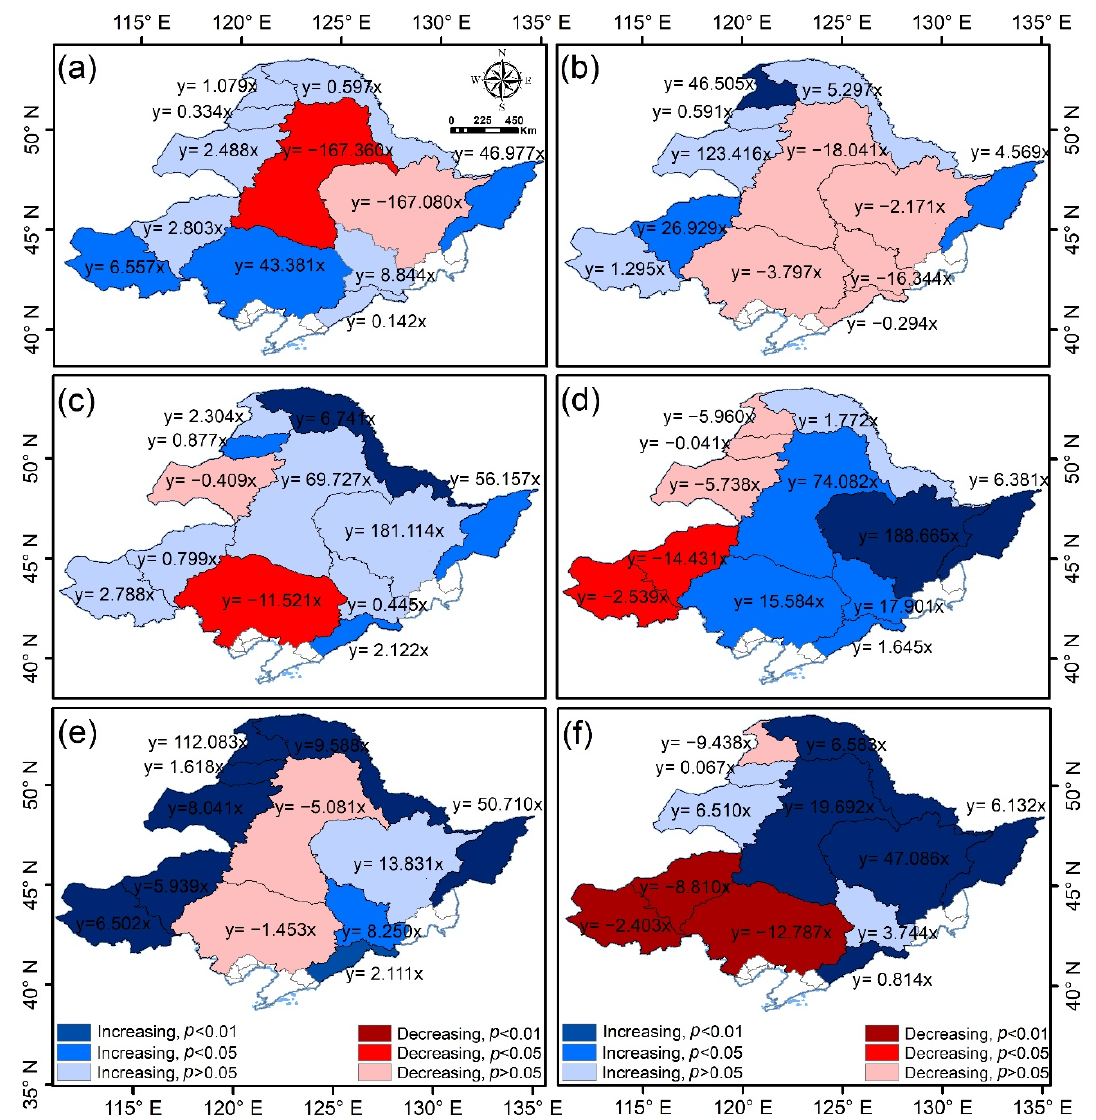
Figure 3. Interannual trends of SSWA and PSWA in the watershed: ( a , b ) are the trends of SSWA and PSWA for 1988–1999, respectively, ( c , d ) are the trends of SSWA and PSWA for 2000–2020, respectively, and ( e , f ) are the trends of SSWA and PSWA for 1988–2020, respectively.